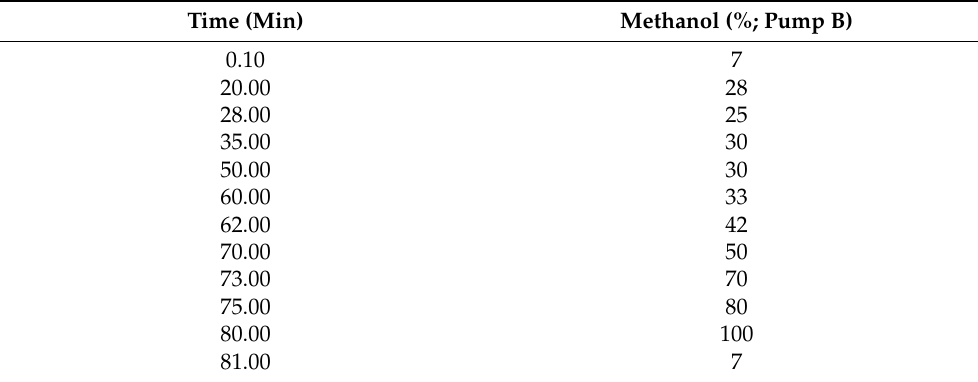
Table 1. HPLC program for phenolic compound